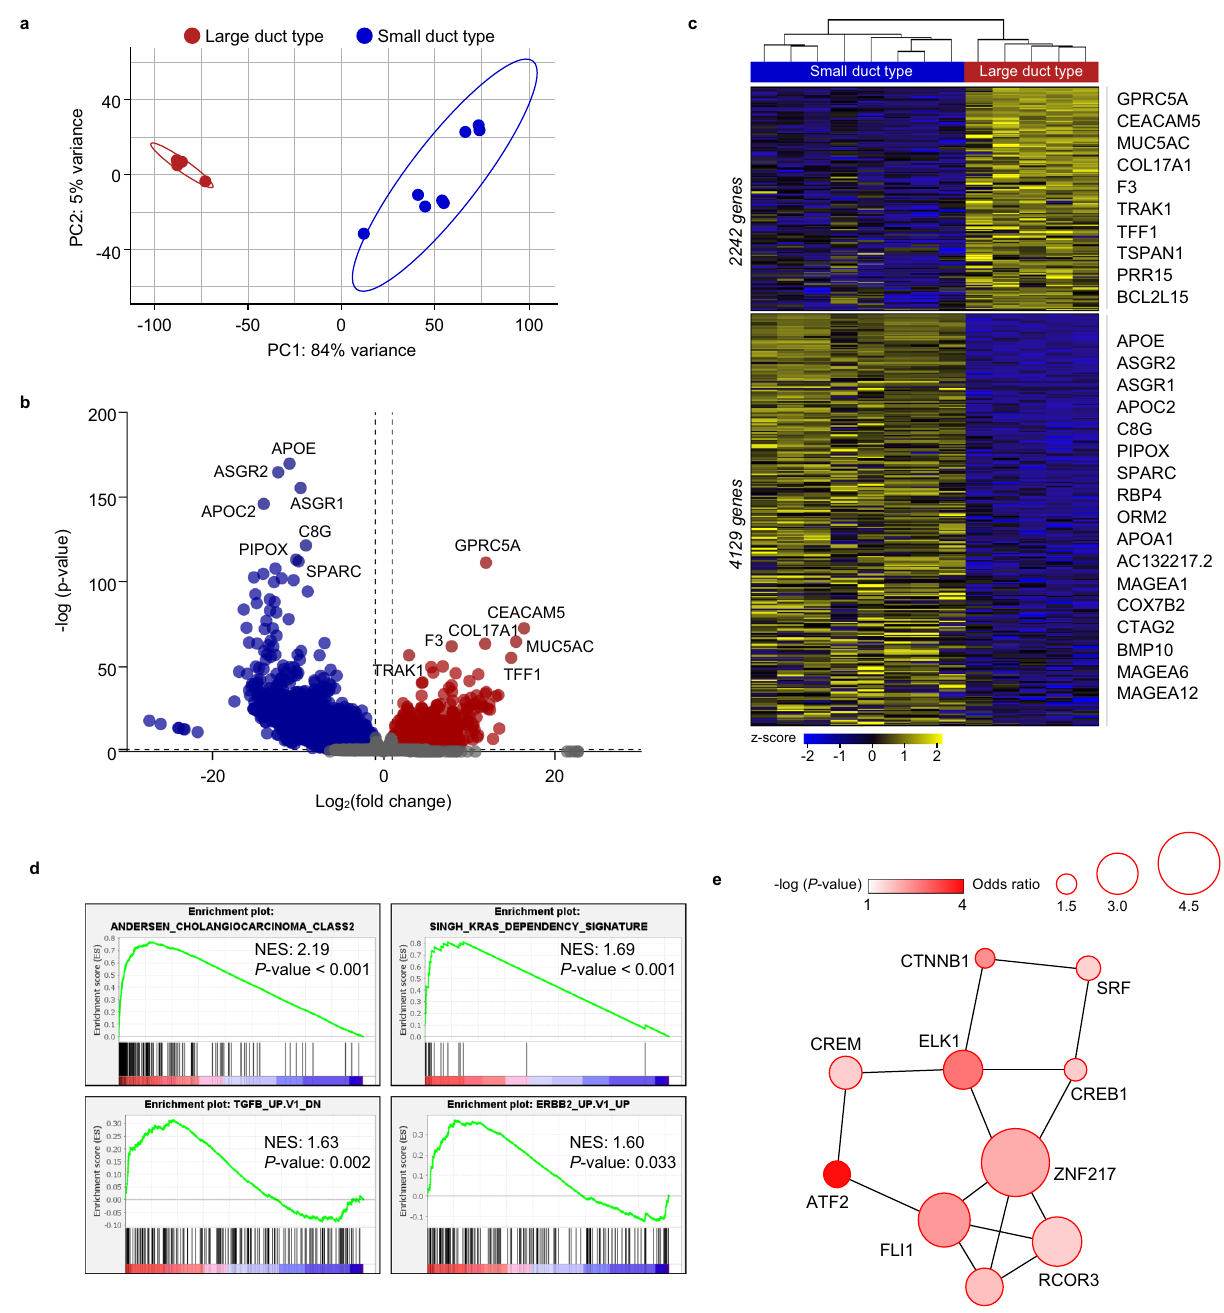
Fig.4|TranscriptomeanalysisofLD-andSD-typecancerorganoids.a PCAplot showing clusters of samples according to transcriptional similarities ( n =13). b , c Volcano plot ( b ) and heatmap ( c ) showing differentially expressed genes (DEGs) between LD (red) and SD (blue) cancer organoids. DEGs were statistically calculated by DESeq method 51 and de fi ned by two criteria: the absolute value of log 2 (fold change) is >1 and the P -value is <0.05. A total of 2242 genes were up- regulated and 4129 genes were down-regulated in LD-type cancer organoids ( n =13).Representativegenesareannotated. d GSEAof2242up-regulatedgenesin LDcancerorganoidsusing gene setsreleasedbythe MolecularSignatureDatabase (MSigDB). Four representative enrichment plots are shown: ‘ cholangiocarcinoma class 2 ’ , ‘ KRAS dependency ’ , ‘ TGF β -up gene ’ , and ‘ ERBB-up gene ’ signatures. Nor- malizedenrichmentscores(NES)and P -valuesareindicated.Kolmogorov – Smirnov test. NES 2.19 and P -value <0.001 for the ‘ cholangiocarcinoma class 2 ’ signature; NES 1.69 and P -value <0.001 for the ‘ KRAS dependency ’ signature; NES 1.63 and P - value0.002for ‘ TGF β -upgene ’ signature;andNES1.60and P -value0.033for ‘ ERBB-